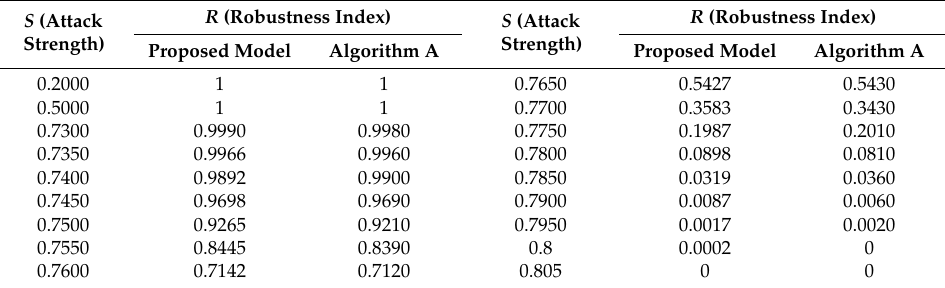
Table 4. Part of robustness results in Experiment 3.